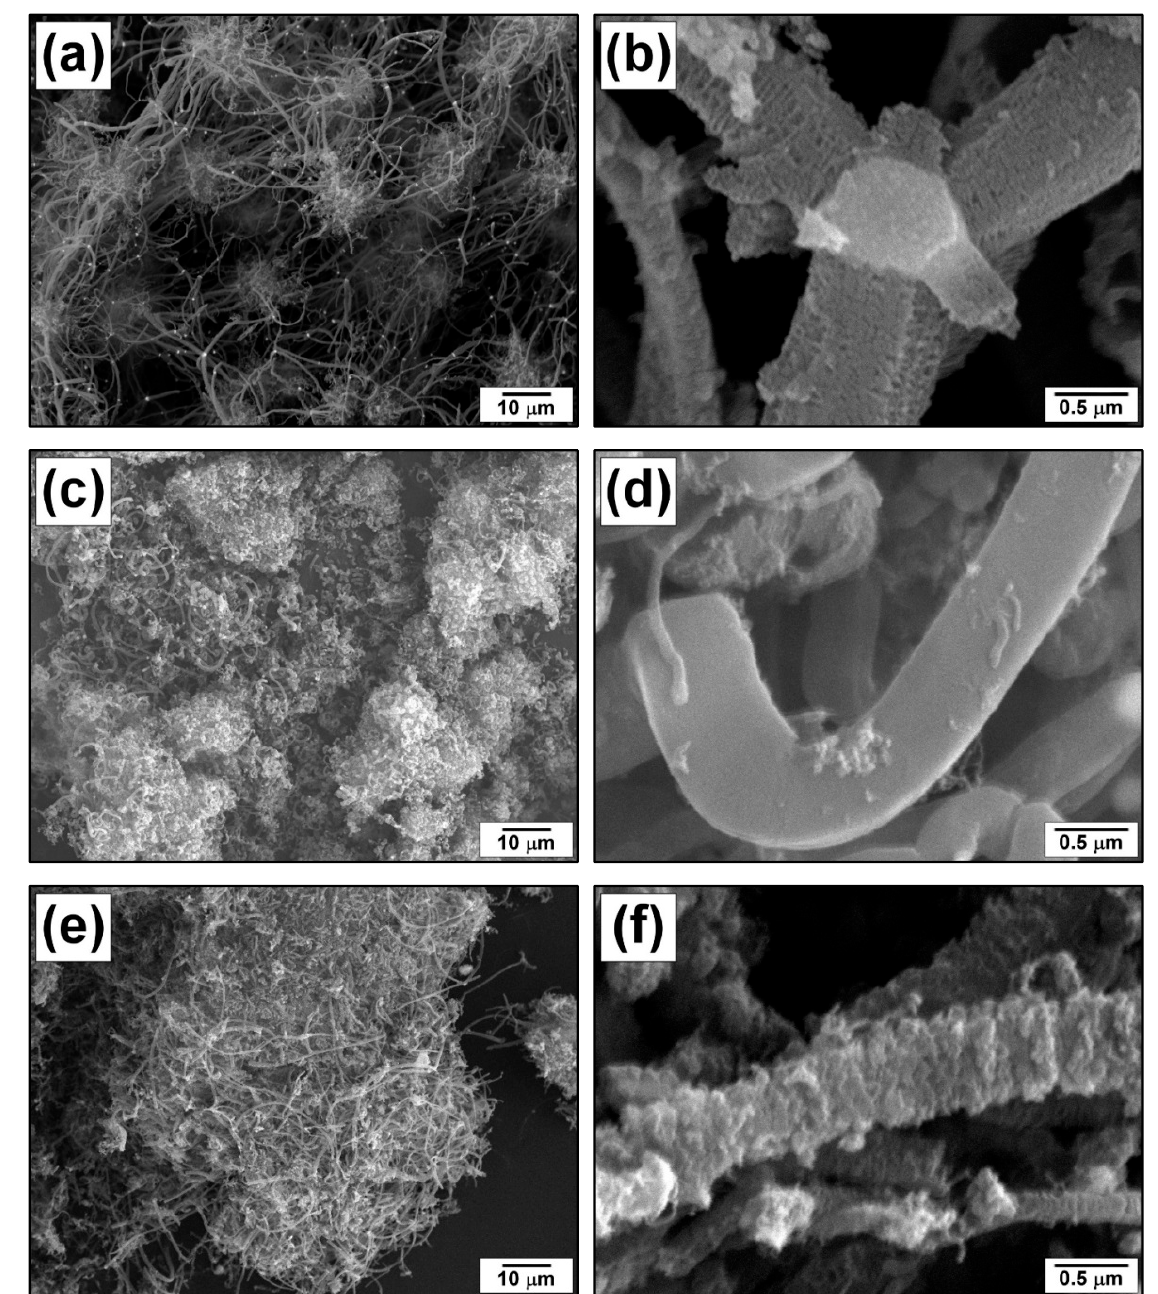
Figure 5. SEM images of the carbon nanostructures produced in different reactors: ( a , b ) reactor #1; ( c , d ) reactor #2; ( e , f ) reactor #3.